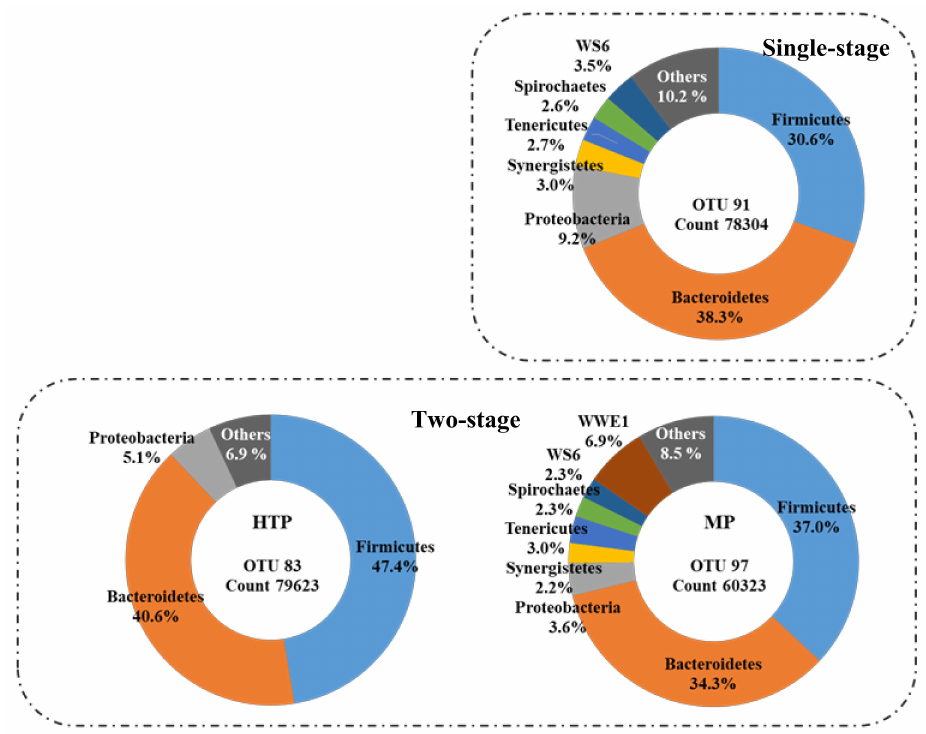
Figure 6. Bactria community at static state period of two-stage and single-stage systems.